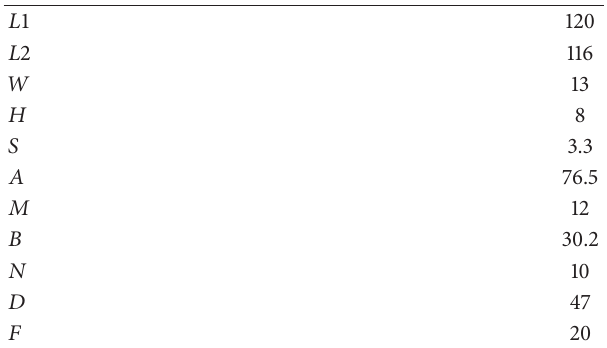
Table 1: Dual-band L-shape PIFA dimensions